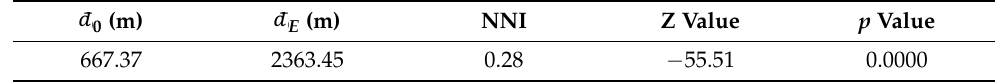
Table 4. Calculation results of nearest neighbor index of rural